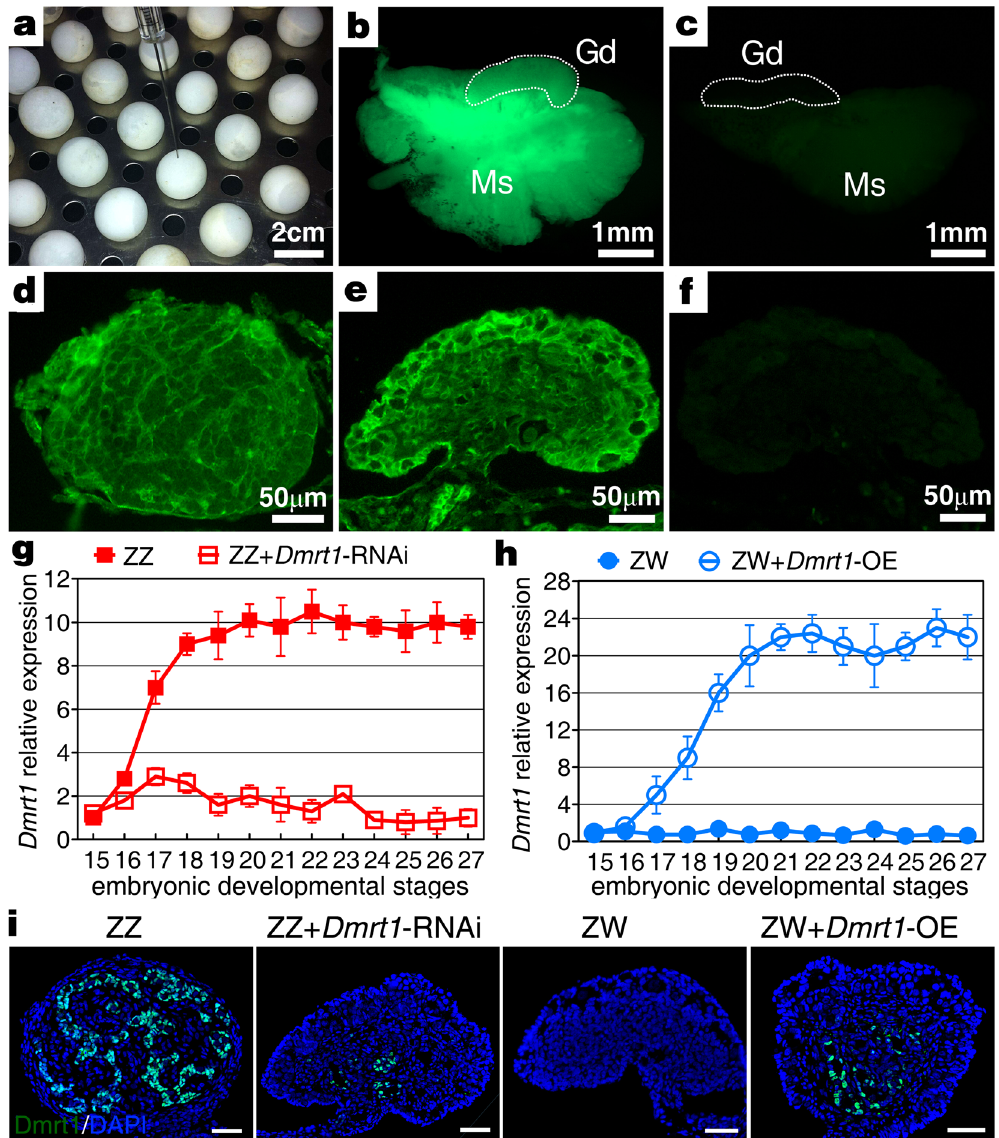
Figure 4. Establishment of a lentivrius mediated gene-modulating method in turtle embryos. ( a ) Chinese soft- shelled turtle embryos were injected with lentiviral vector at stage 14 before sexual differentiation, using a metal Hamilton needle. ( b ) Approximately 55% of embryos of stage 25 infected with the lentiviral vector showed robust and widespread GFP expression in gonad-mesonephros complexes (GMCs). ( c ) No GFP signals was seen in the negative control GMCs. Gd, gonad; Ms, mesonephros. ( d , e ) Robust GFP expression in sections of gonads treated with LV- Dmrt1 or LV- Dmrt1 -shRNA, determined by immunofluorescence. ( f ) No GFP expression were seen in the negative control gonadal sections. ( g , h ) The mRNA expression change of Dmrt1 in gonads treated with LV- Dmrt1 - shRNA or LV- Dmrt1 was examined by qRT-PCR. Data are shown as means ± S.D. N ≥ 3. ( i ) The Dmrt1 immunofluorescence showed significantly down-regulation in ZZ gonad with LV- Dmrt1 - shRNA treatment and ectopic expression in ZW gonad with LV- Dmrt1 -OE treatment at stage 25, respectively. Scale bars are 50 μ